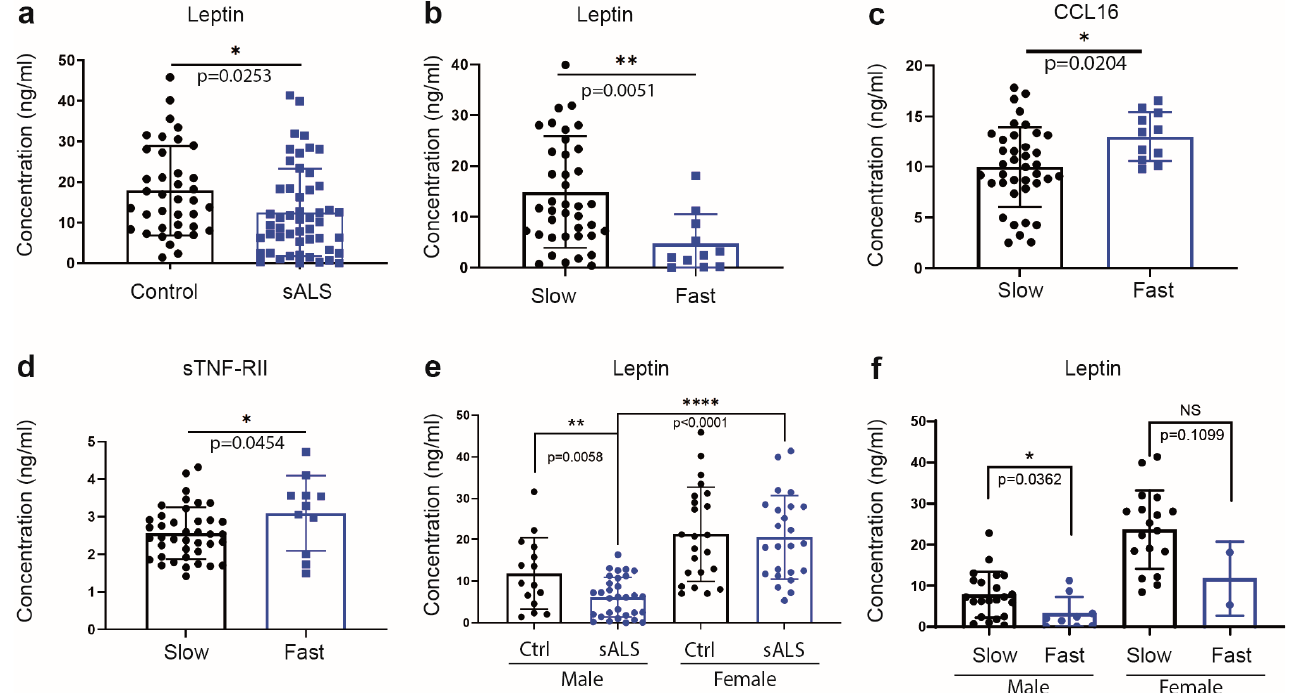
Figure 3. Plasma levels of leptin, CCL16 and sTNF-RII measured by ELISA. ( a ) concentration (ng/mL) of leptin measured by ELISA in healthy controls (38) and sALS (51). ( b , d ) Concentration (ng/mL) of leptin ( b ), CCL16 ( c ) and sTNF-RII ( d ) measured by ELISA in slow (40) and fast (11) progressing ALS patients. ( e , f ) Concentration (ng/mL) of leptin in sALS and controls sub-grouped by sex ( e ) and by sex and rate of progression ( f ) (Data are mean ± SEM * p ≤ 0.05, ** p < 0.01, **** p < 0.0001, NS, not significant).